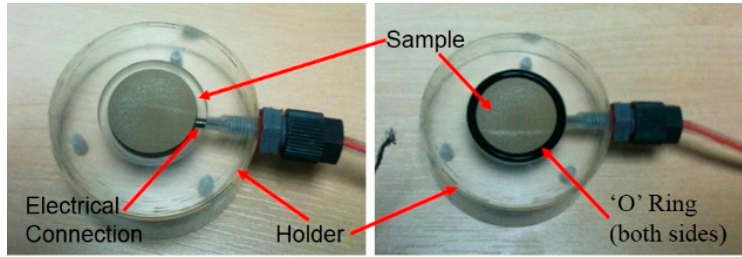
Figure 1. Designed sample holder for electrochemistry tests.